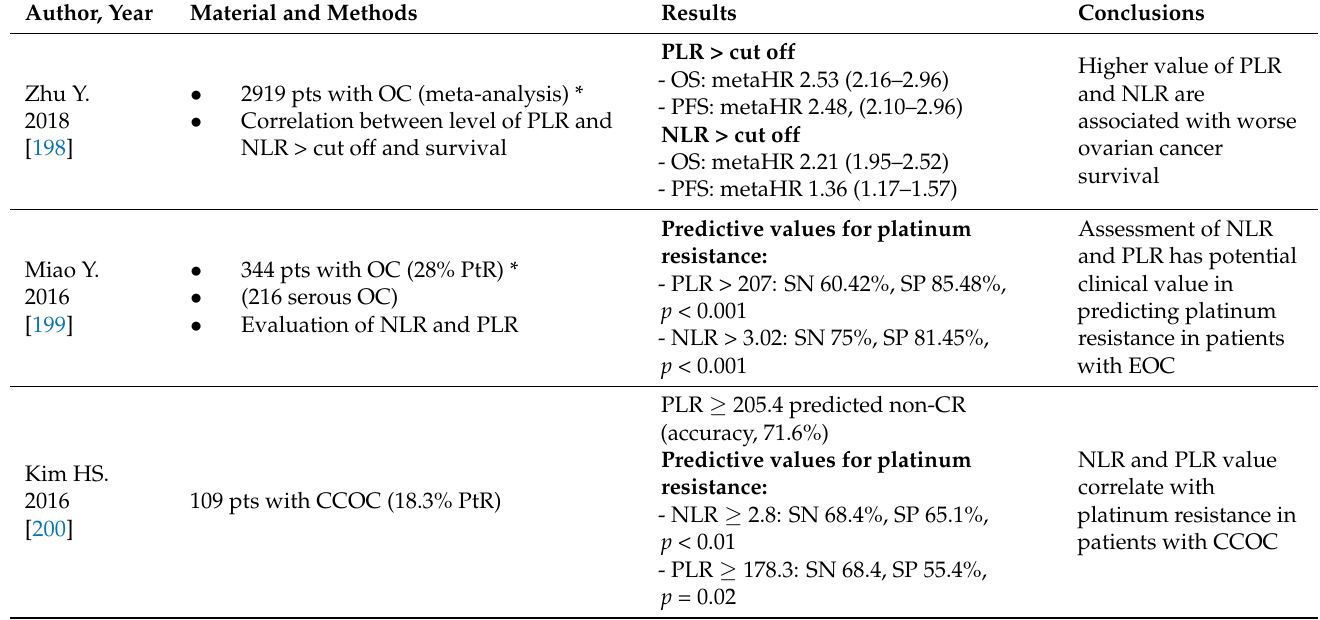
Table 6. Most relevant evidence about the potential role of PLR and NLR in PtR